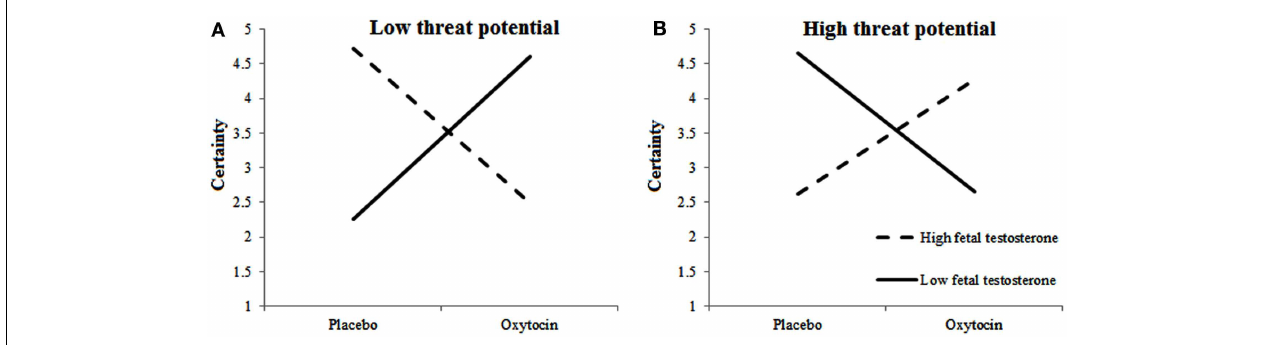
FIGURE 3 | Fetal testosterone exposure moderates effects of oxytocin on certainty of inclusion decisions. Certainty about including low-threat targets (A) is lower and about high-threat targets (B) is higher among individuals with high fetal testosterone exposure when given oxytocin rather than placebo.